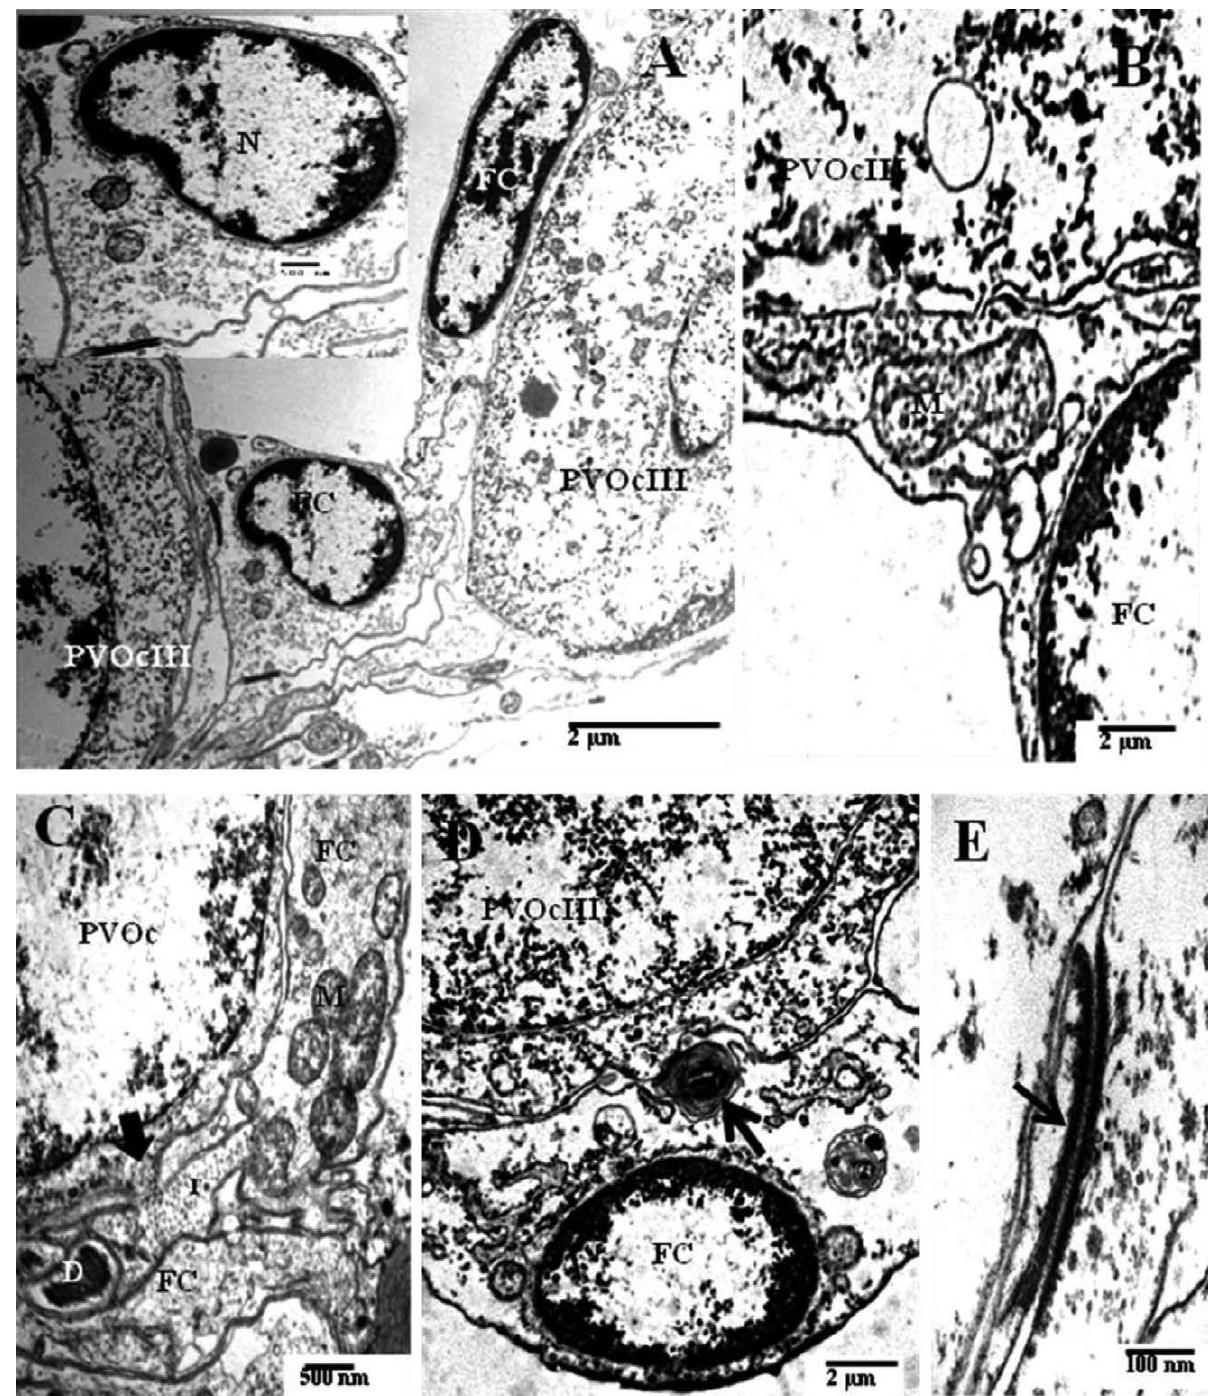
Fig. 7. – A, TEM of a previtellogenic oocyte III (PVOcIII) surrounded by follicle cells (FC) just before its detachment from the cluster; note the deeply folded plasma membrane of the follicle cells forming channels throughout the cytoplasm; Inset: large oblong nucleus (N) of a fol- licle cell. B, intercellular bridge between follicle cell and oocyte. C, mitochondria (M), rough endoplasmic reticulum (RER) and Golgi vesicles (Ve) in the cytoplasm of a follicle cell; arrow indicates ribosome in the intercellular bridges between follicle cell and oocyte. D, multivesicular bodies (arrow) in the cytoplasm of a follicle cell and in the space between a follicle cell and an oocyte. E, small desmosomal junction (arrow) between two adjacent follicle